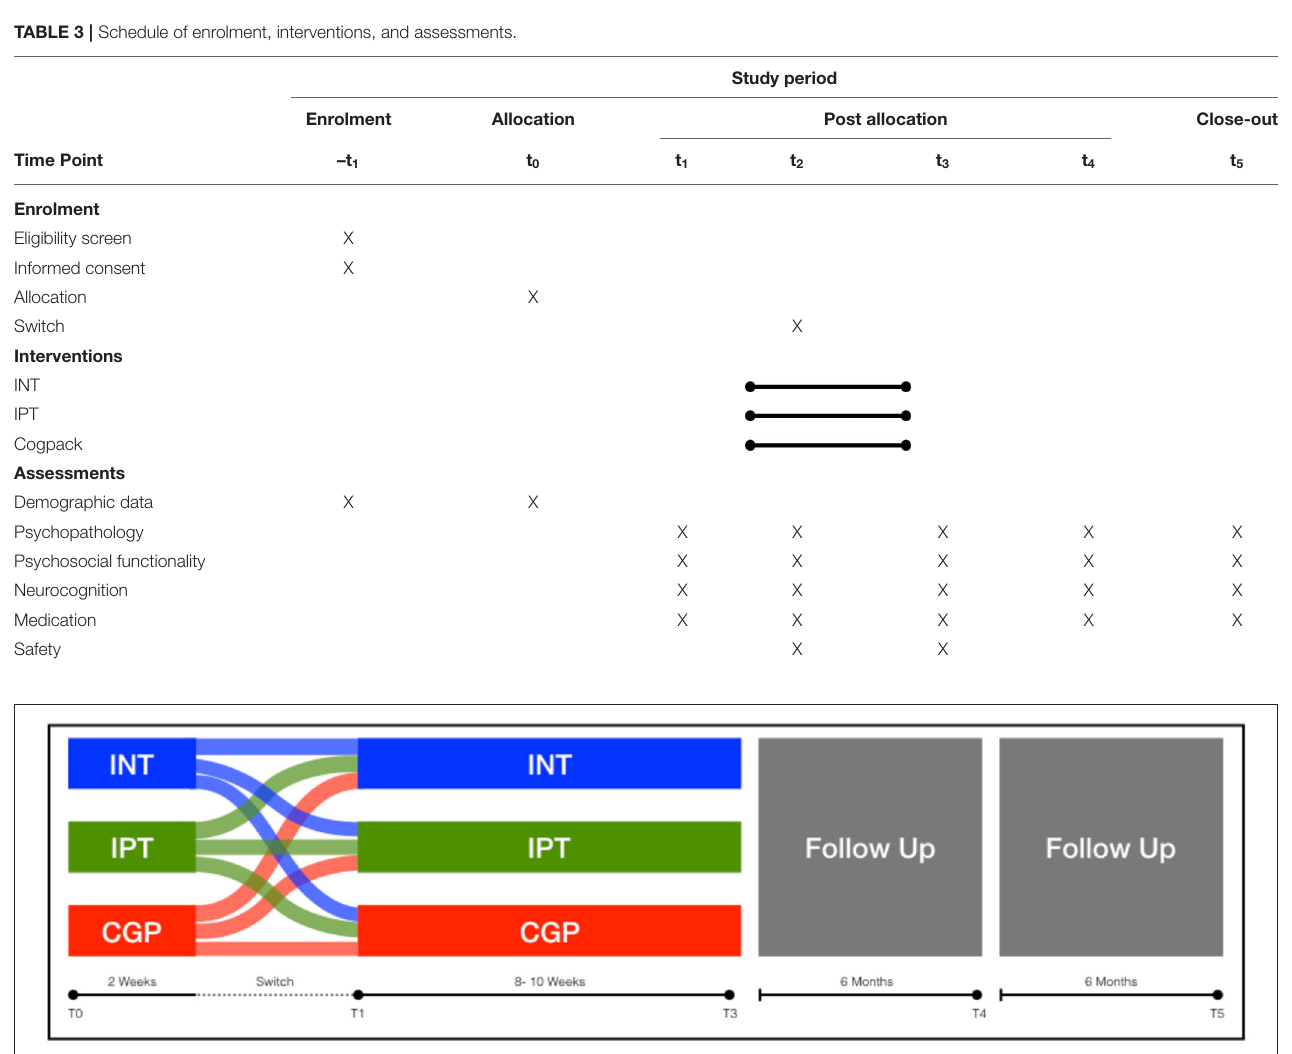
FIGURE 1 | Study flow